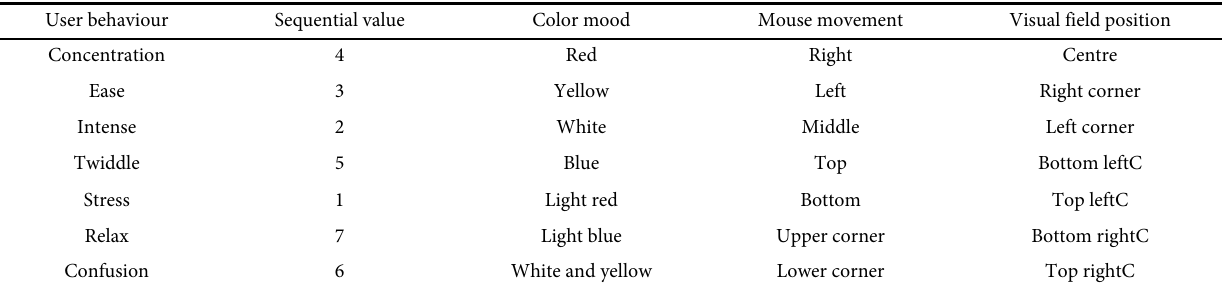
Table 1 Anticipated behaviour attributes to the complex game interface: The colors create rendered cascaded 3D object detector as gaze point for the different users’ moods which could be overlapped at some coordinates.